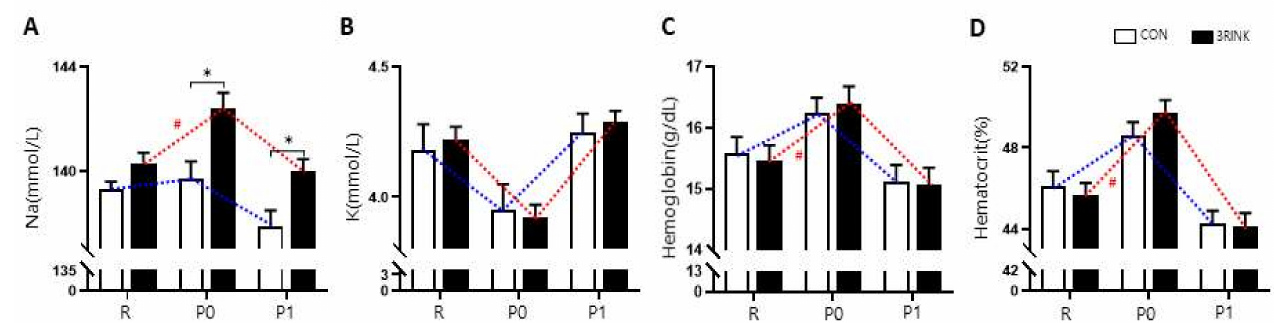
Figure 3. Changes in body electrolytes and hemoglobin/hematocrit according to the timing of fluid intake. Data for ( A ) Sodium, ( B ) Potassium ( C ) Hemoglobin ( D ) Hematocrit represent the mean and SEM ( n = 10 per group). Significance for variance was denoted as * p < 0.05, and differences (Blue and red dotted line) between groups for change over time were denoted as # p < 0.05. R = Rest, P0 = Right after exercise, P1 = 1 h after exercise.